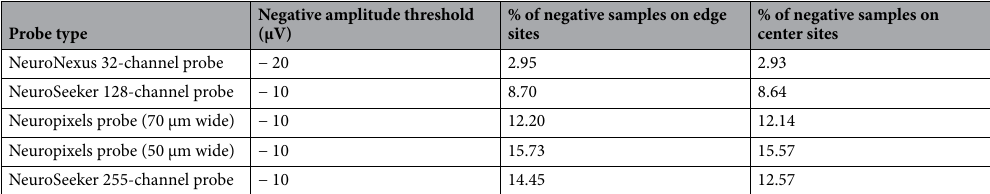
Table 4. Maximal negative amplitude thresholds below which significantly more edge samples were detected.